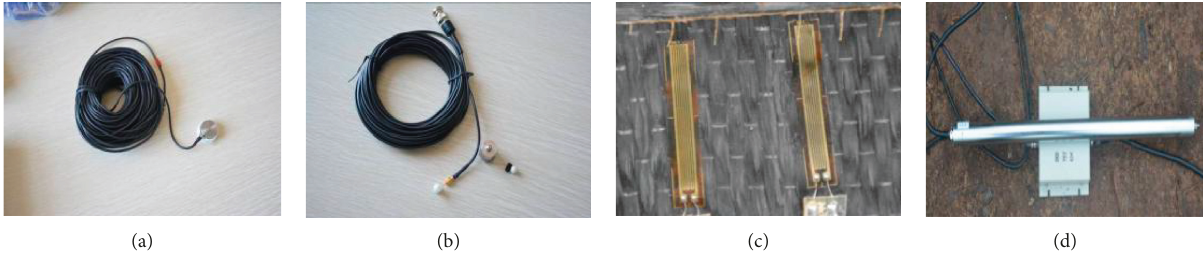
Figure 8: Types of sensors used in the tests. (a) Pressure sensor. (b) Acceleration sensor. (c) Strain gauge. (d) Displacement